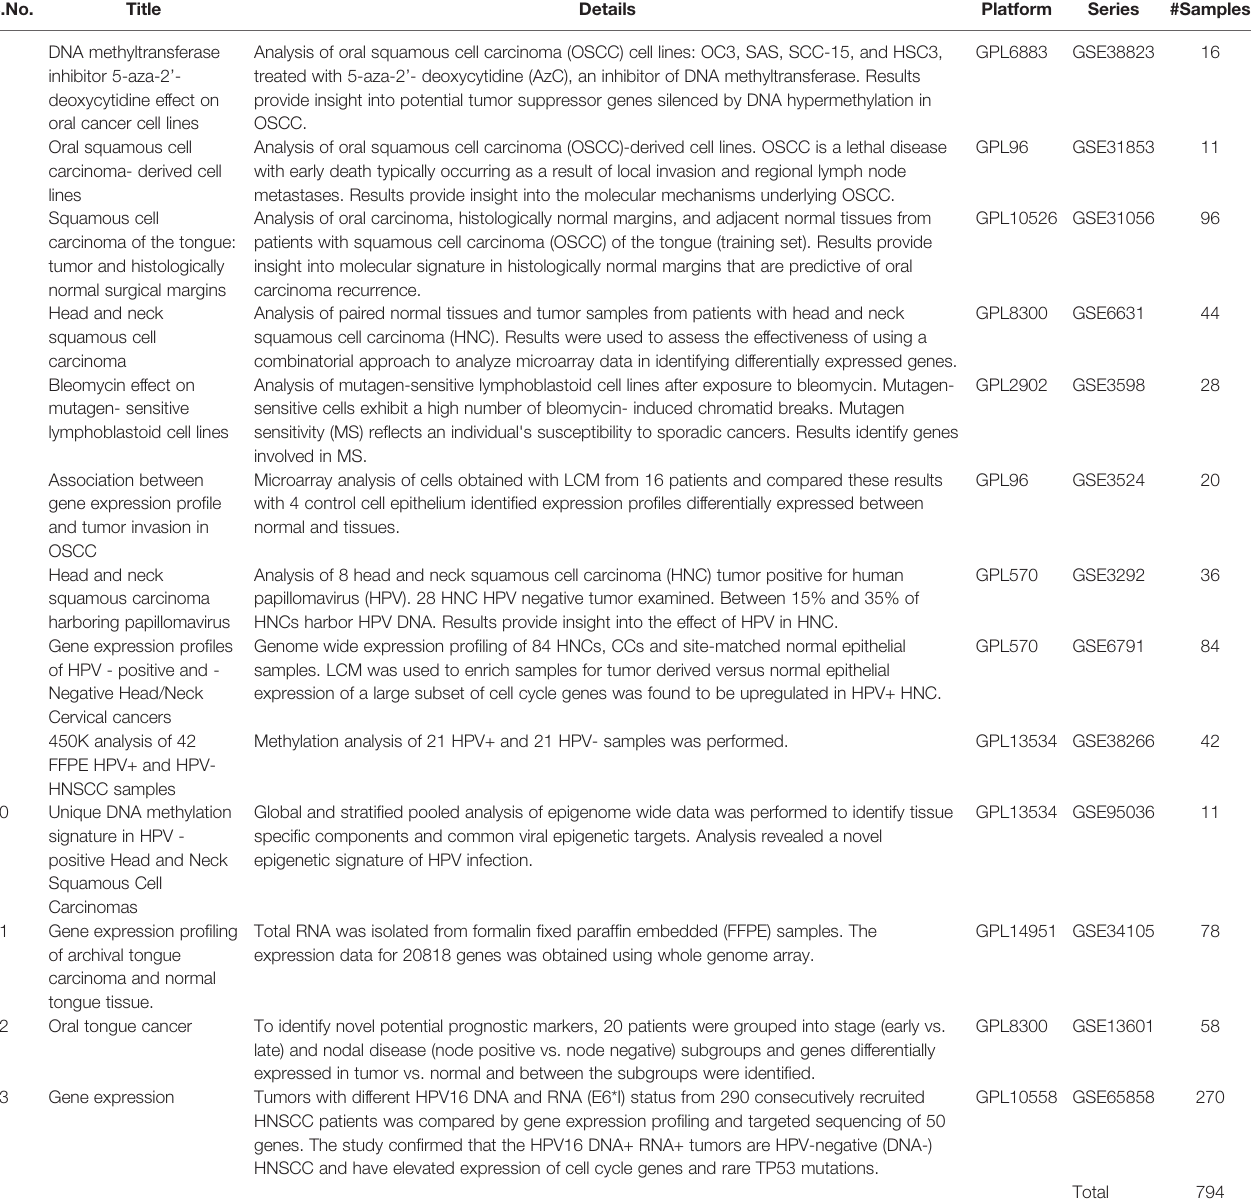
TABLE 2 | List of GEO DataSets (expression pro fi ling by array) related to HNC studies for data re- analysis.